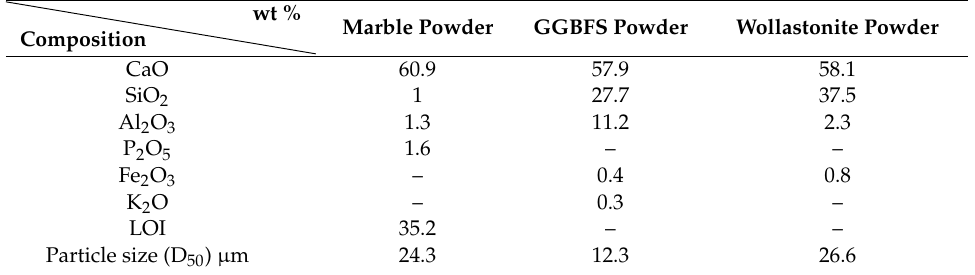
Table 1. Powder chemical composition and particle size. GGBFS, ground-granulated blast-furnace